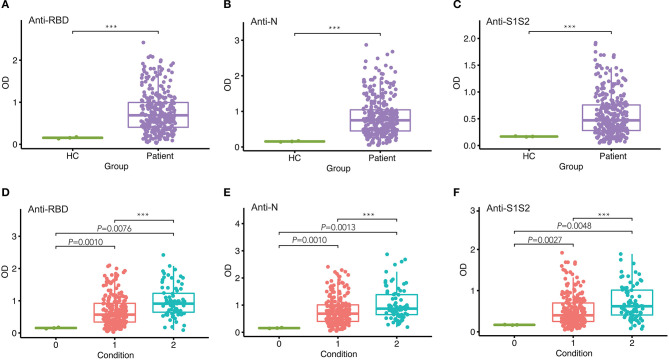
Comparison of antibody responses between different groups. (A–C) Comparison of anti-RBD (A), anti-N (B), and anti-S1S2 (C) antibody responses between healthy controls (HC) and infected patients. (D–F) Pairwise comparison of anti-RBD (D), anti-N (E), and anti-S1S2 (F) antibody responses between healthy (“0”), mild/moderate (“1”), and severe (“2”) conditions. P-values were calculated by Student's t-test for (A–C) and by one-way ANOVA for (D–F). P-values < 0.05 were considered significant, and labeled with ***P < 0.001.